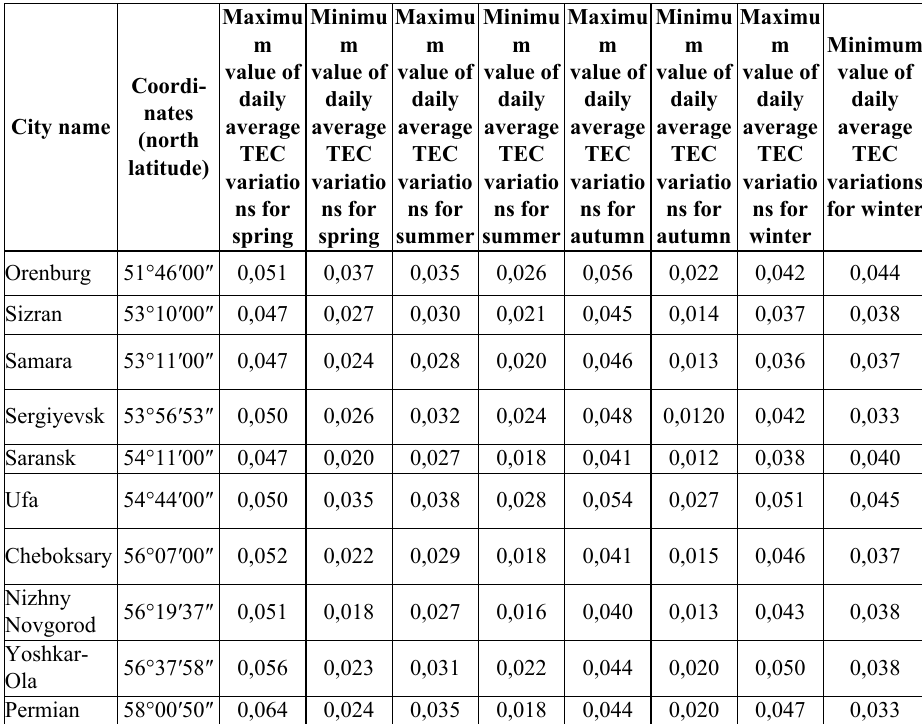
Table 1. The results of calculations of TEC